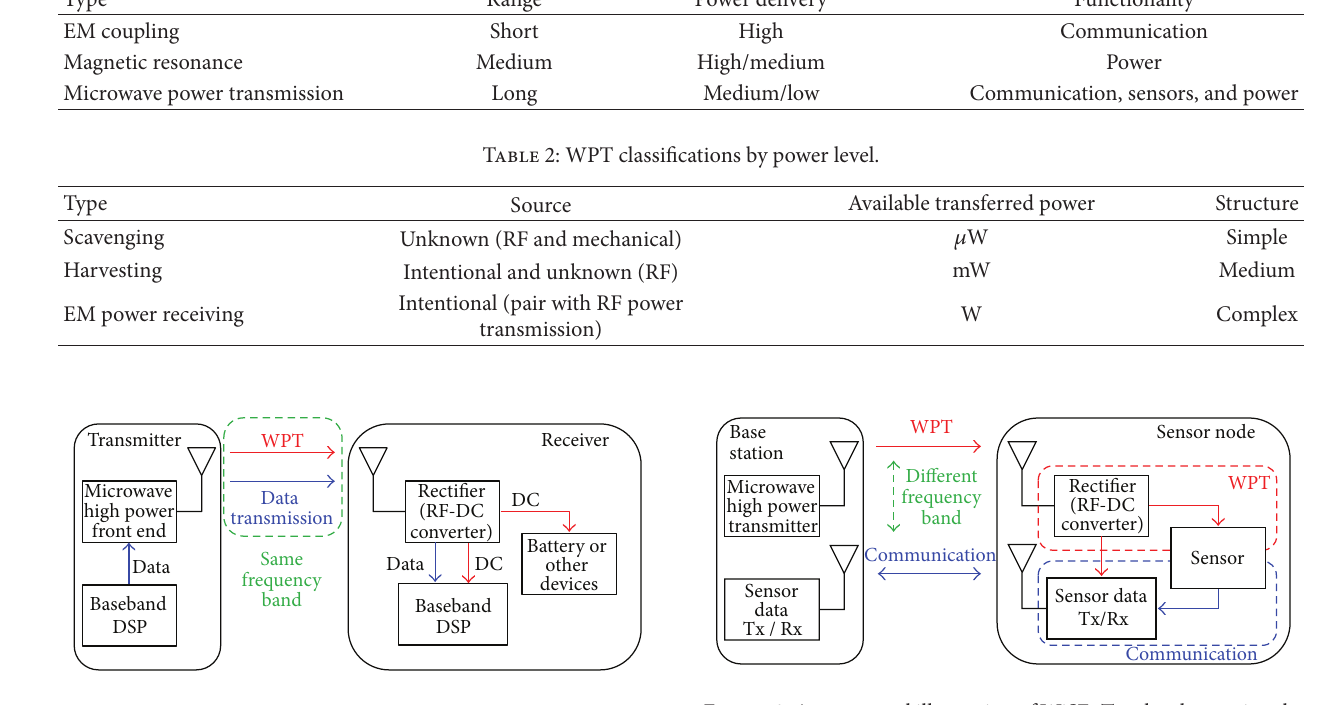
Figure 1: A conceptual illustration of WiCoPT technology using the microwave band.